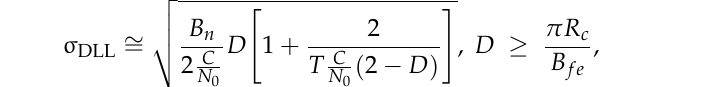
Figure 13. Percentage of continuous time intervals, a point of each curve identifies a time interval duration T (on the x -axis) and the corresponding percentage (on the y -axis) of continuous time intervals equal or longer than T.